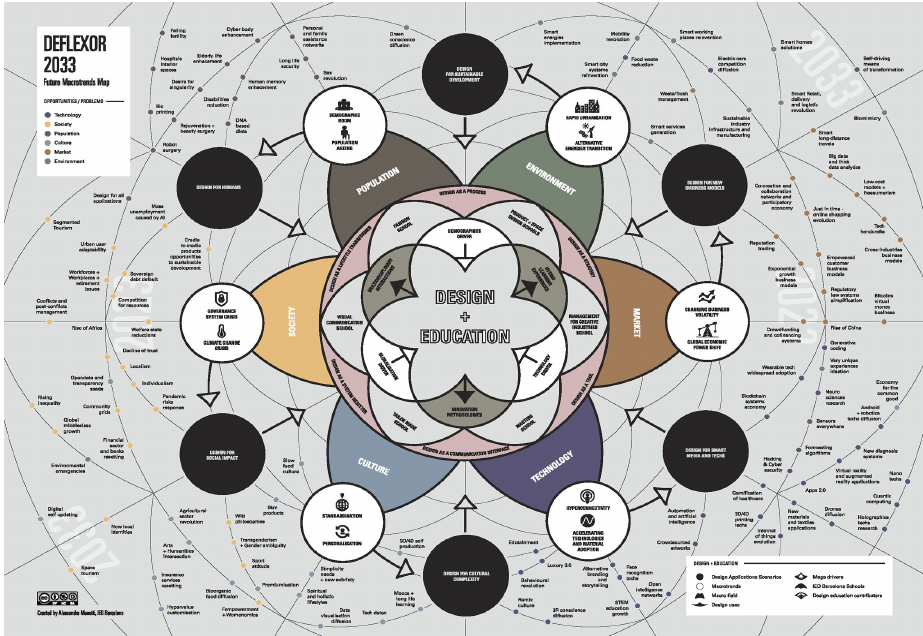
Figure 1. General scheme of the universe created for Deflexor. Although the words written in the nodes cannot be read, the picture gives an idea of the complexity of categories (big fields), concepts (words) and relations (arrows) of the model. More information can be found in